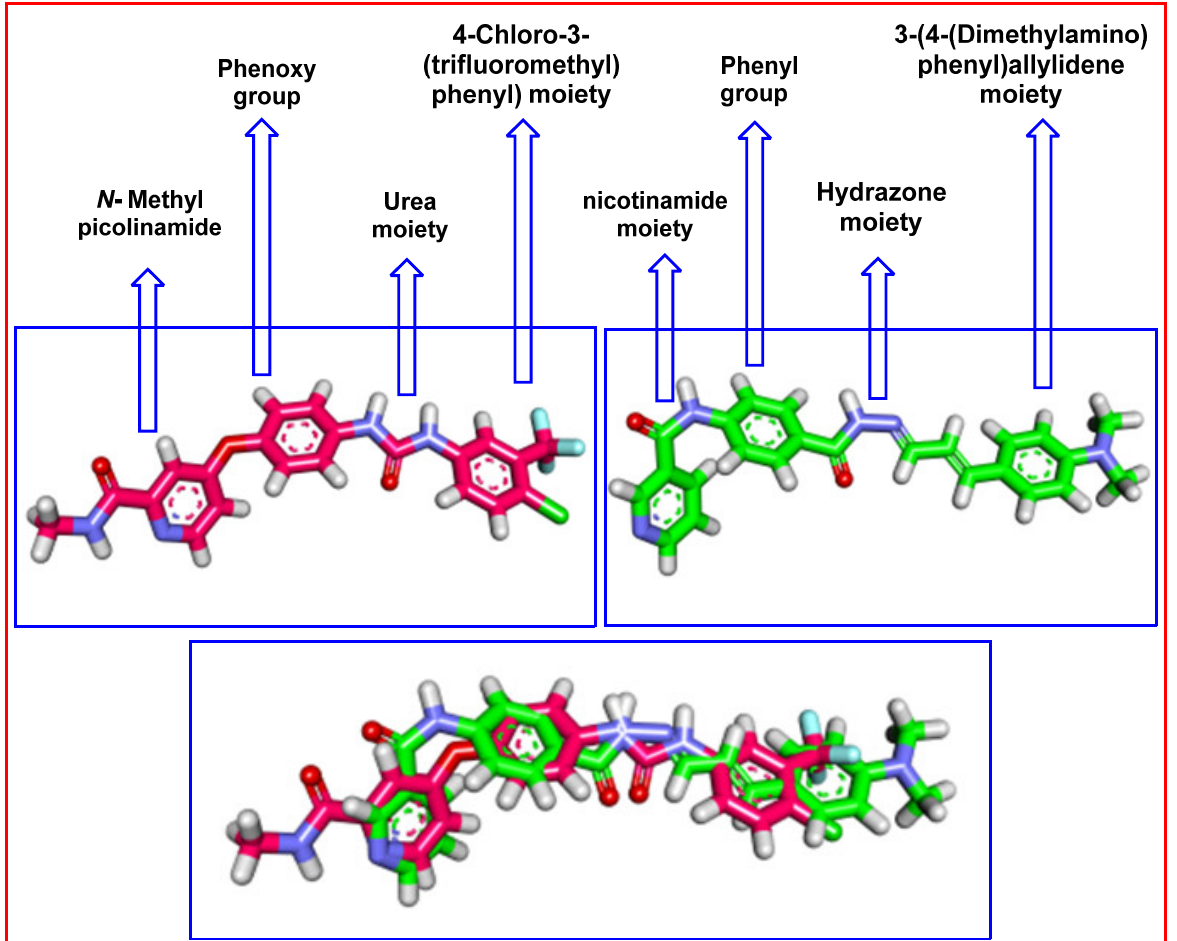
Figure 12. Flexible alignment of compound 8 (green) with sorafenib (pink), showing the same orientation.